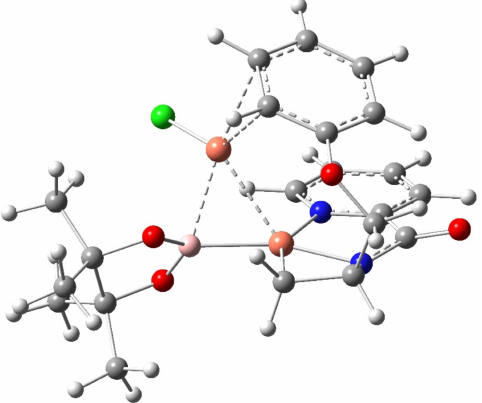
Figure 4. Structure of intermediate I3a for compound 1c with highlighted the η 6 - coordination of the phenyl ring with the copper atom